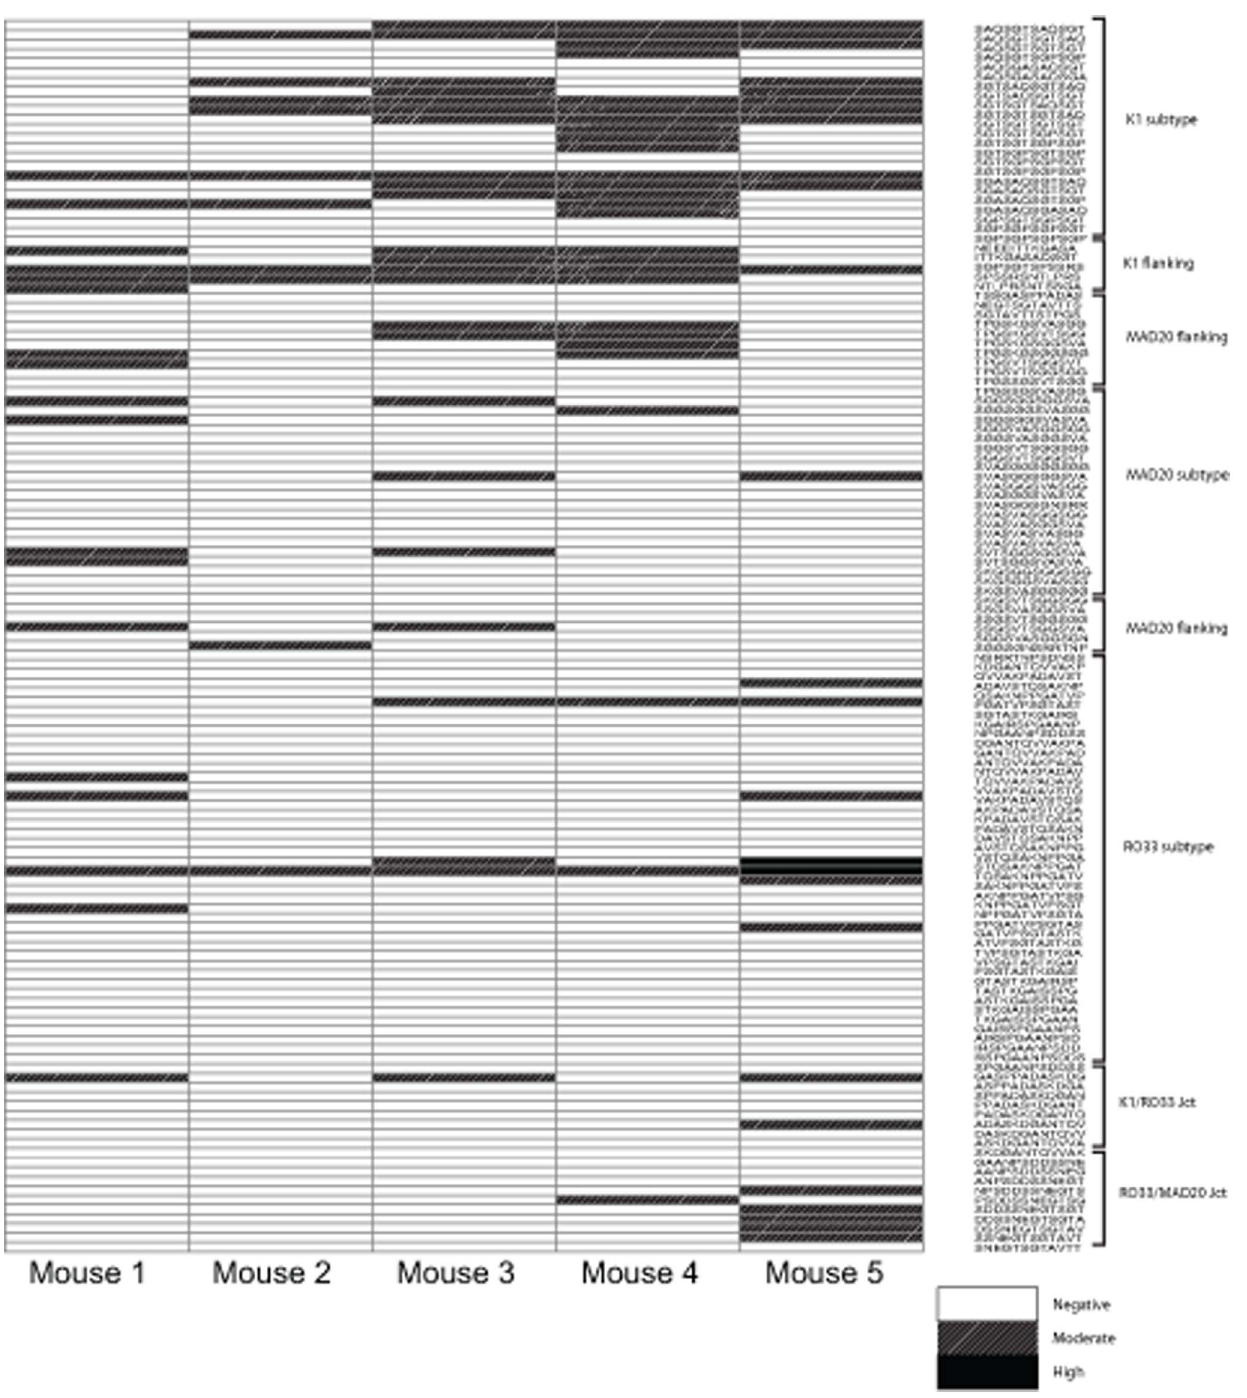
Figure 5. Epitope mapping of sera from MSP-1-BBM immunized mice by recognition of peptide epitopes within the MSP-1 Block 2 region of the MSP-1-BBM construct. A series of 133 N-terminally biotinylated dodecapeptides, representing the sequence diversity of all three Block 2 serotypes were used in ELISA to map the antibody specificities present in the sera of immunized animals. Reactivity with individual peptides is shown as shaded boxes, with the depth of shading of each box representing the strength of reactivity of a 1:500 dilution of sera with each peptide. The sequences and Block 2 serotype (K1, MAD20 and RO33) of each peptide are indicated down the right hand side of the diagram. doi:10.1371/journal.pone.0087198.g005 often have slow electrophoretic mobility [31], we confirmed the 10–45 kDa were observed, and may indicate slight contamination identity of the 60 kDa band as MSP-1-BBM by tandem mass with host cell proteins or the presence of degradation products, which were not detected by the 12.2 mAb, which detects an N- spectrometry (see Materials and Methods). Some minor bands of